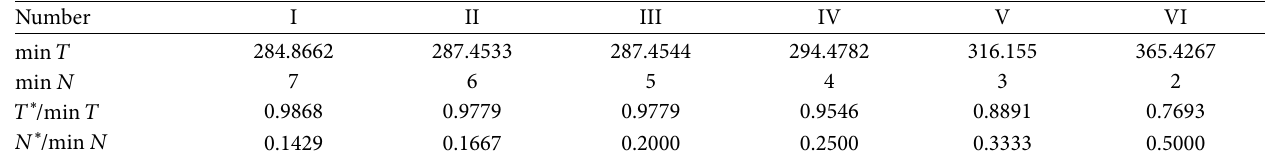
Table 3: The optimal result by ACA.